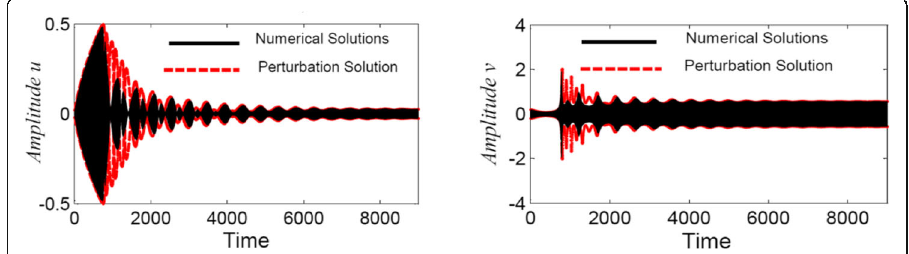
Fig. 16 Comparison between RK and MSP methods at Ω 1 ≅ ω 1 , Ω 2 ≅ 2 ω 1 , ω 1 ≅ 3 ω